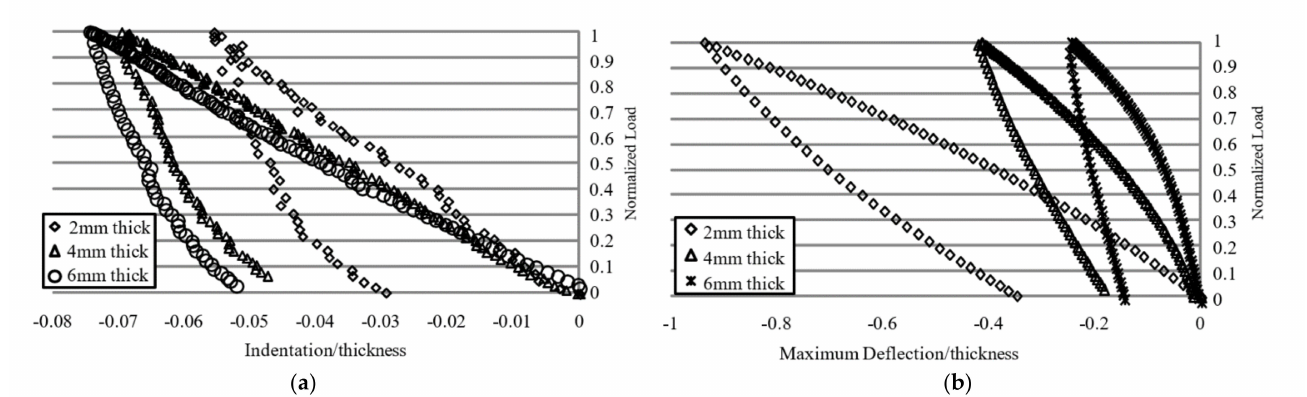
Figure 9. ( a ) Normalized contact load as a function of the indentation/thickness ratio for different specimen thicknesses, ( b ) normalized contact load as a function of the maximum deflection/thickness ratio for different specimen